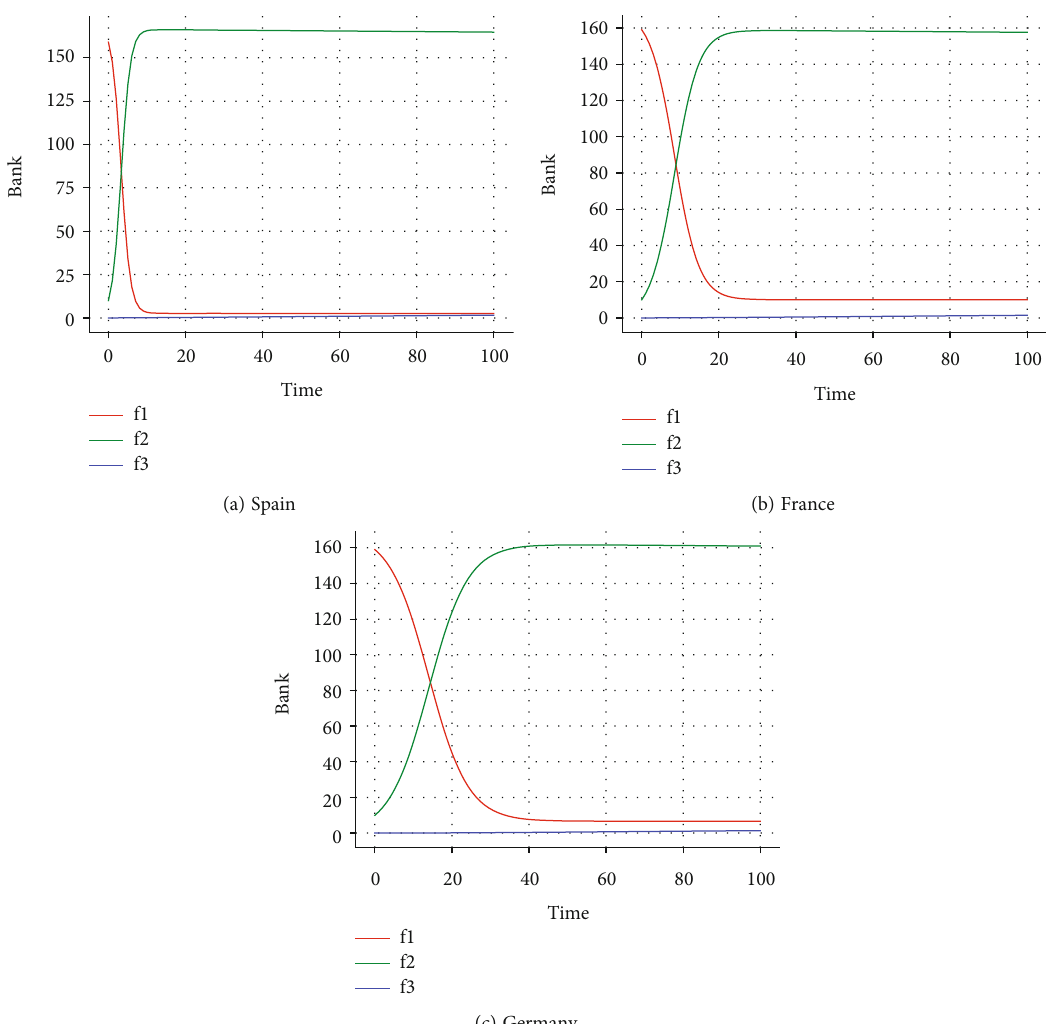
Figure 4: Liquidity risk in Spain, France, and Germany behavior over time with α